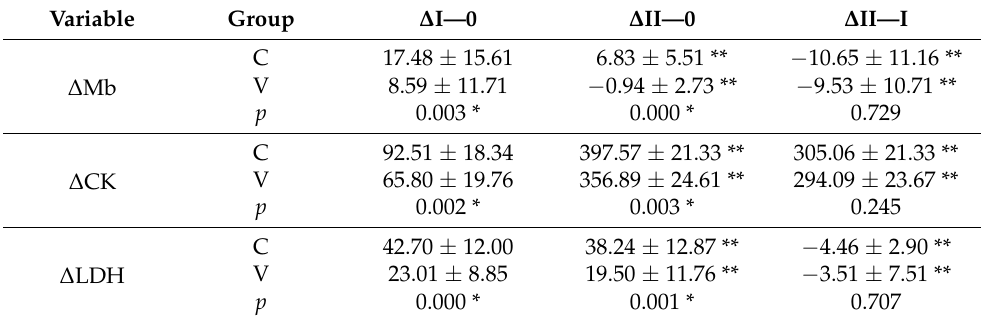
Table 4. Differences in the concentration of myoglobin (Mb), activity of creatine kinase (CK), and lactate dehydrogenase (LDH) in the blood 1 h and 24 h after exercise in the group subjected to post-exercise therapy (V) and in the control group (C).